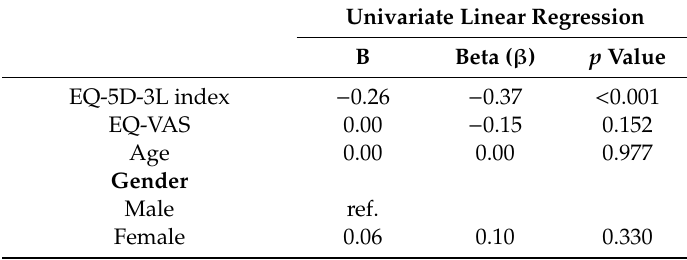
Table 5. Length of stay (Log10) with the EQ-5D-3L index, EQ-VAS, and comprehensive geriatric assessment parameters at